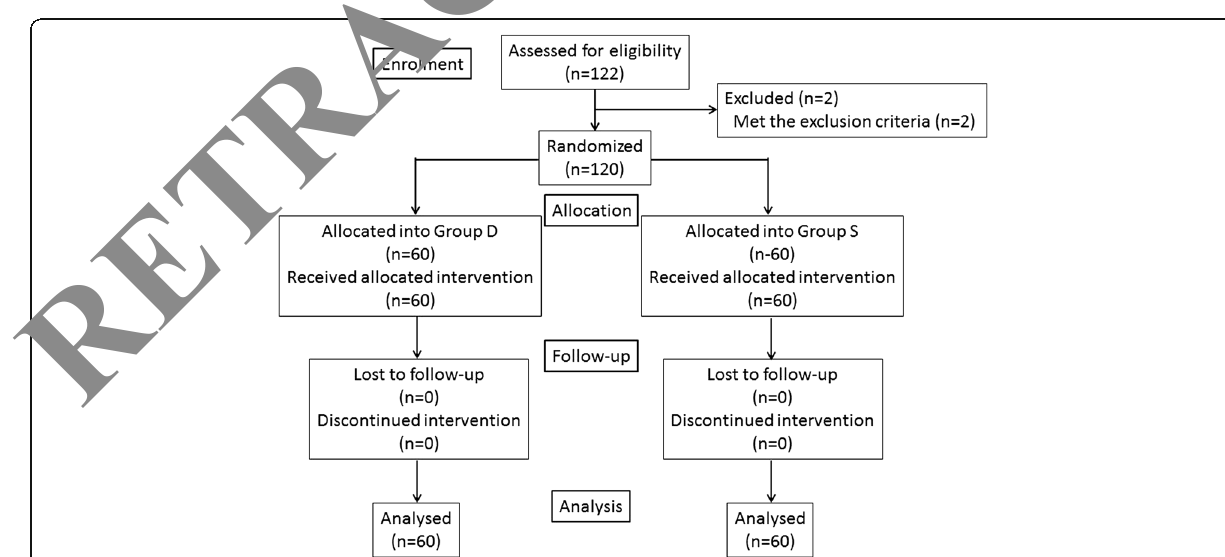
Fig. 1 Flow diagram of patient assignment to study group. D desflurane, S sevoflurane. Two patients were excluded from the study due to a history of psychological disorder. All eligible patients completed the